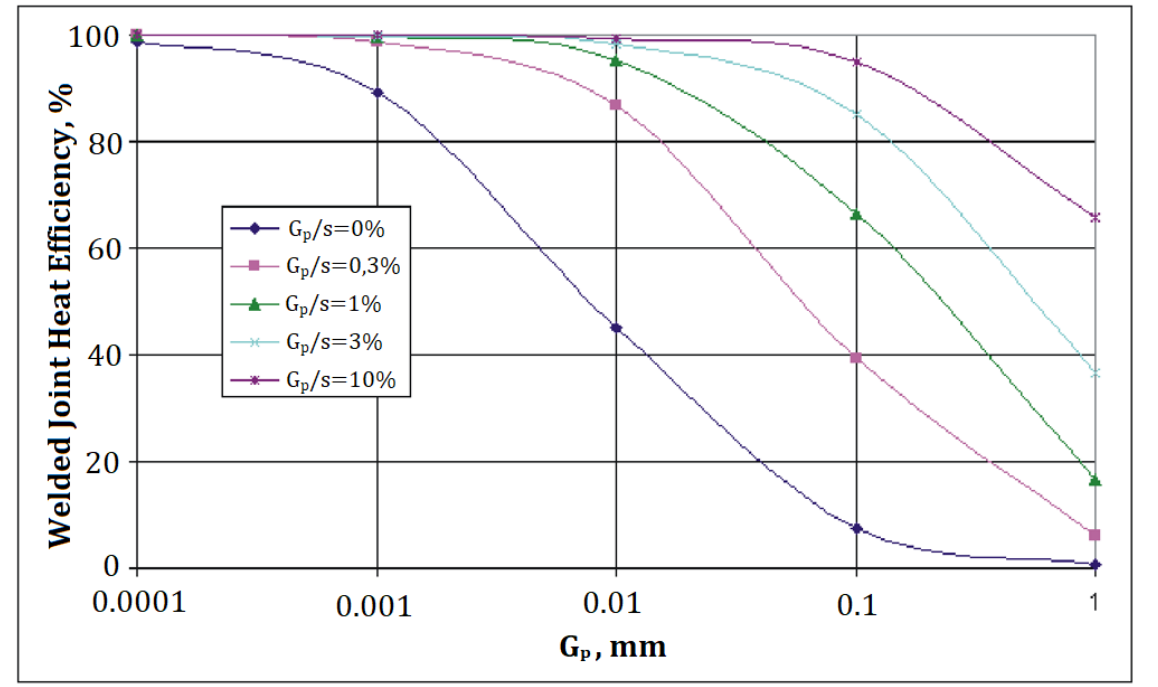
Figure 14. The relative heat flux flowing through a fin bonded to a tube by means of a welded joint with incomplete penetration in the function of the gap width between the fin and the tube (G p ).